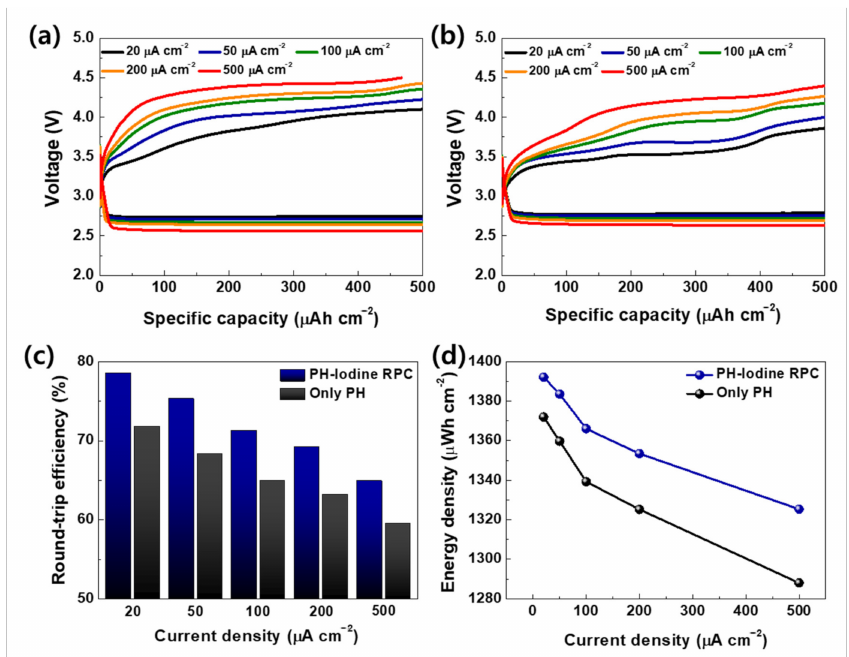
Figure 5. High-rate performance of the samples. Plots of voltage vs. specific capacity measured at di ff erent current densities of ( a ) Only PH and ( b ) PH-Iodine RPC samples. ( c ) Comparison of round-trip e ffi ciency for the samples. ( d ) Plots of energy density vs. current density for the